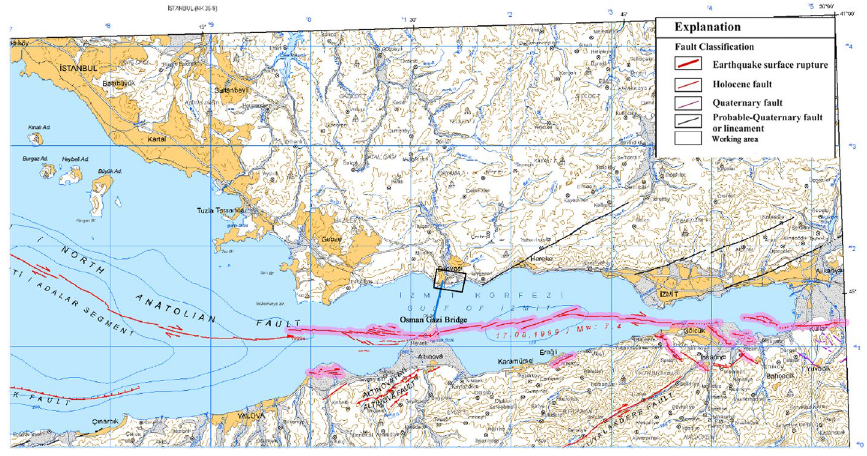
Fig. 4 Seismotectonic map of the Marmara Region of Türkiye